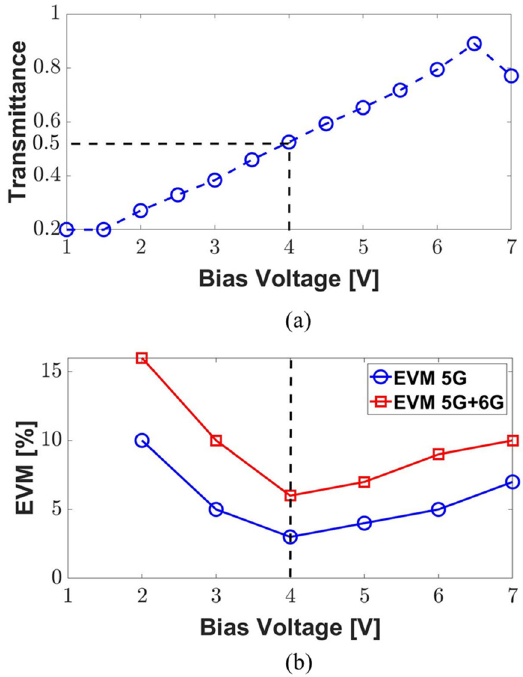
Figure 4. ( a ) MZM measured transmission power in the optical domain concerning bias voltage and ( b ) EVM with and without 6G signal for varying bias voltages. Table 1. Testbed link component parameters.